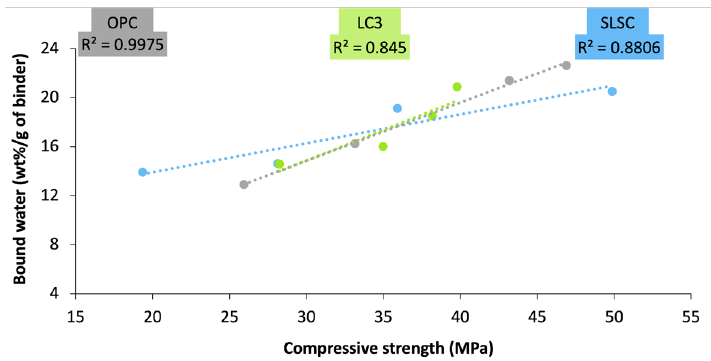
Figure 4. Comparison of the hydrated cement bound water with the cement mortar compressive